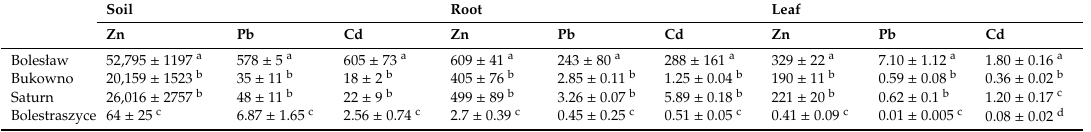
Table 1. Concentrations of total Zn, Pb, and Cd ( µ g g − 1 ) in soils as well as in roots and leaves of white clover from the non-polluted reference area and the polluted sites in Bolesław, Bukowno, and Saturn. Soil Root Leaf Zn Pb Cd Zn Pb Cd Zn Pb Cd Bolesław 52,795 ± 1197 a 578 ± 5 a 605 ± 73 a 609 ± 41 a 243 ± 80 a 288 ± 161 a 329 ± 22 a 7.10 ± 1.12 a 1.80 ± 0.16 a Bukowno 20,159 ± 1523 b 35 ± 11 b 18 ± 2 b 405 ± 76 b 2.85 ± 0.11 b 1.25 ± 0.04 b 190 ± 11 b 0.59 ± 0.08 b 0.36 ± 0.02 b Saturn 26,016 ± 2757 b 48 ± 11 b 22 ± 9 b 499 ± 89 b 3.26 ± 0.07 b 5.89 ± 0.18 b 221 ± 20 b 0.62 ± 0.1 b 1.20 ± 0.17 c Bolestraszyce 64 ± 25 c 6.87 ± 1.65 c 2.56 ± 0.74 c 2.7 ± 0.39 c 0.45 ± 0.25 c 0.51 ± 0.05 c 0.41 ± 0.09 c 0.01 ± 0.005 c 0.08 ± 0.02